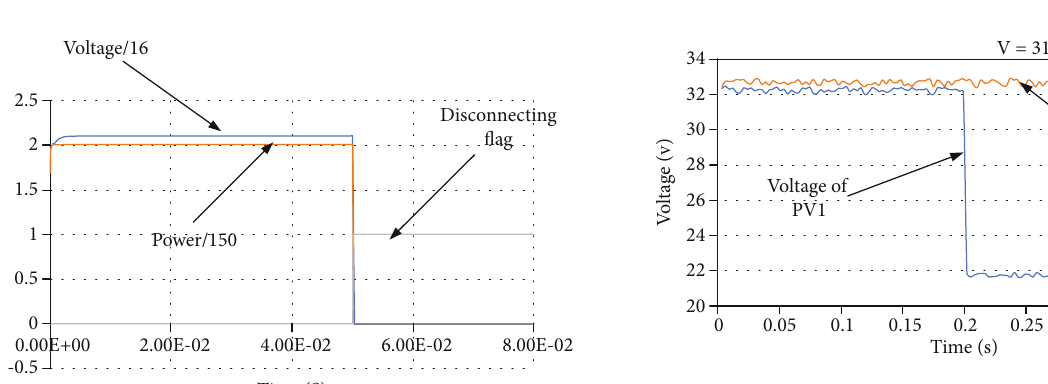
Figure 45: The output voltage of PV1 and PV2, when the bypass diode of panel 3 has failed.